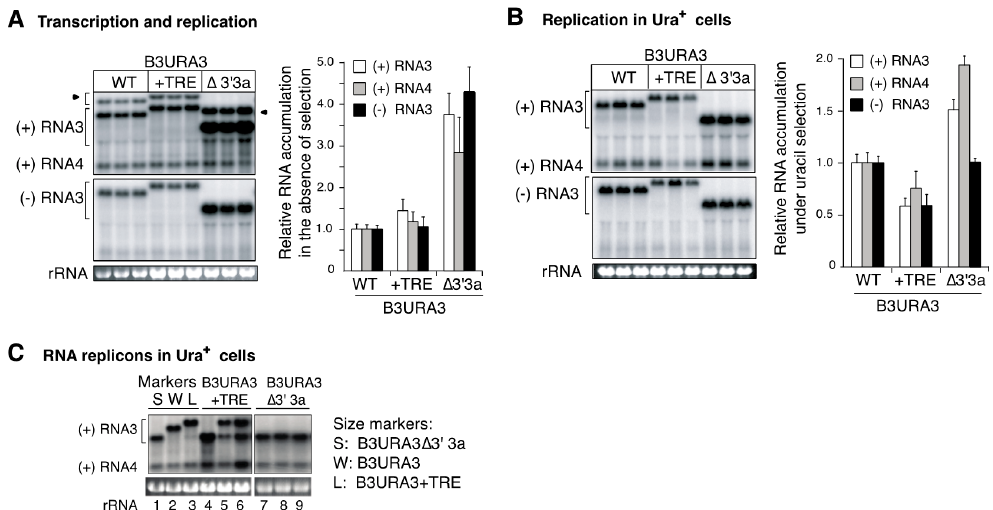
Figure 4. Replication of B3URA3 + TRE and B3URA3 Δ 3 ′ 3a, and intramolecular RNA recombination in spherule-forming conditions. ( A ) Accumulation of B3URA3 + TRE and B3URA3 Δ 3 ′ 3a in actively transcribing cultures in the absence of selection. In yeast expressing BMV 1a and 2a pol , B3URA3 or its derivatives were transcribed from the GAL1 promoter in liquid cultures for 72 h (9–10 yeast generations). Equal amounts of cells were harvested for RNA extraction and analysis by Northern blotting with 32-P labeled, strand-specific URA3 probes. Representative Northern blots are shown. Arrowheads indicate transcripts before ribozyme cleavage. RNA3 and RNA4 of positive and negative polarity are indicated are indicated by (+) and ( − ), respectively. Ethidium bromide staining of 18S rRNA is indicated at the bottom. The histogram shows RNA accumulation relative to B3URA3, and bars represent the average and standard error of six biological replicates. B3URA3 Δ 3 ′ 3a accumulated to higher levels than B3URA3 and B3URA3 + TRE ( p < 0.01); ( B ) Accumulation of B3URA3 + TRE and B3URA3 Δ 3 ′ 3a in Ura + cells. Individual Ura + colonies were grown in liquid cultures (8 ml) under uracil selection. Total RNA was extracted and processed as in (A). Positive strand RNA3 and RNA4 in B3URA3 Δ 3 ′ 3a accumulated to higher levels than B3URA3 and B3URA3 + TRE ( p < 0.01). ( C ) Detection of intramolecular RNA recombinants in Ura + colonies after plasmid launching of B3URA3 + TRE. B3URA3 and B3URA3 Δ 3 ′ 3a were processed in parallel as size markers. For each construct, twenty Ura + colonies obtained after plasmid launching were individually grown in liquid cultures (8 mL) lacking uracil, the RNA extracted, and analyzed as in (A). Lane 4 shows B3URA3 Δ 3 ′ 3a replacing B3URA3 + TRE. Lanes 5 and 6 show both B3URA3 + TRE and B3URA3 Δ 3 ′ 3a. B3URA3 Δ 3 ′ 3a did not suffer genetic modifications (lanes 7, 8 and 9). Ethidium bromide staining of 18S rRNA is indicated at the bottom.